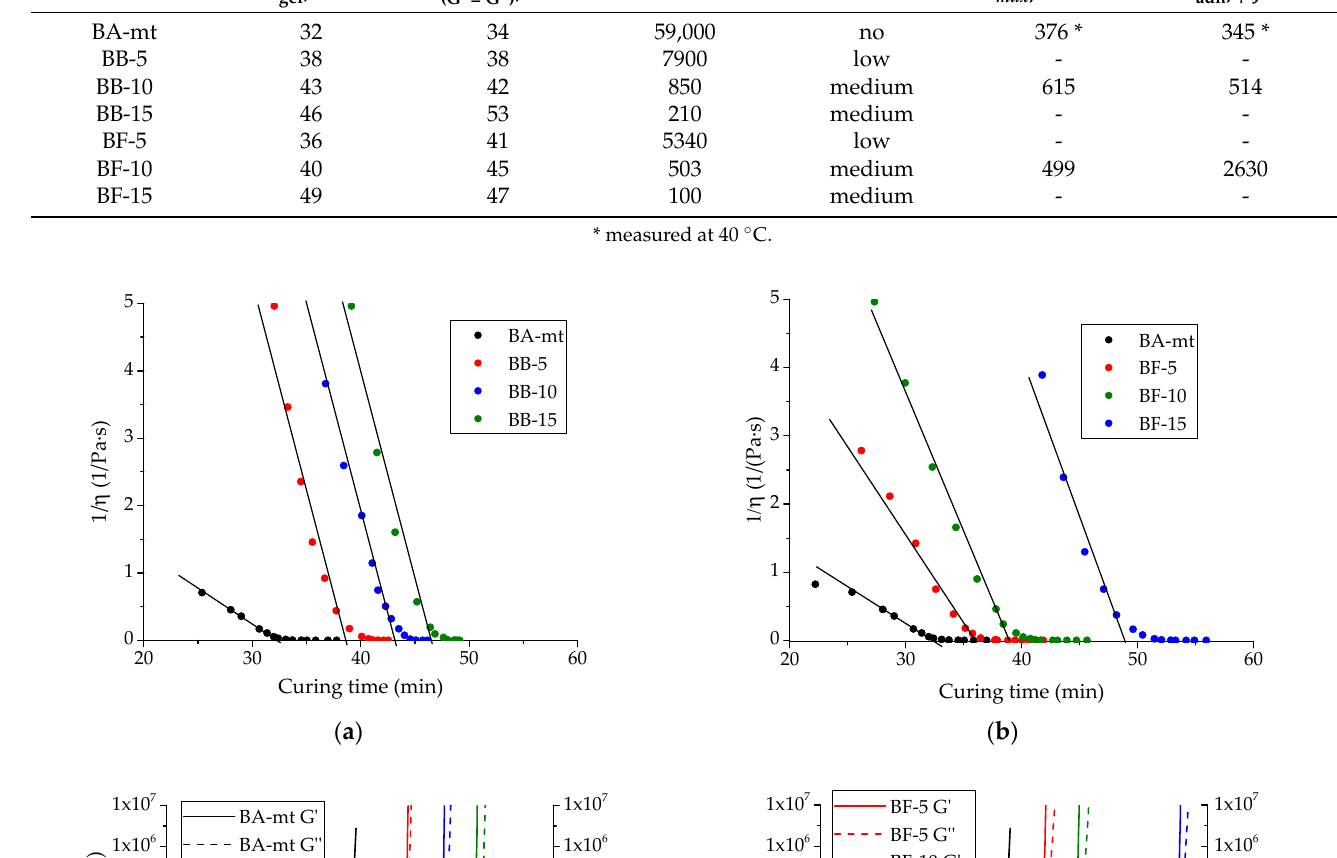
Table 3. Gelation and crossover points at 180 ◦ C, viscosity at 40 ◦ C and tackiness at 25 ◦ C for compositions under study. Formulation